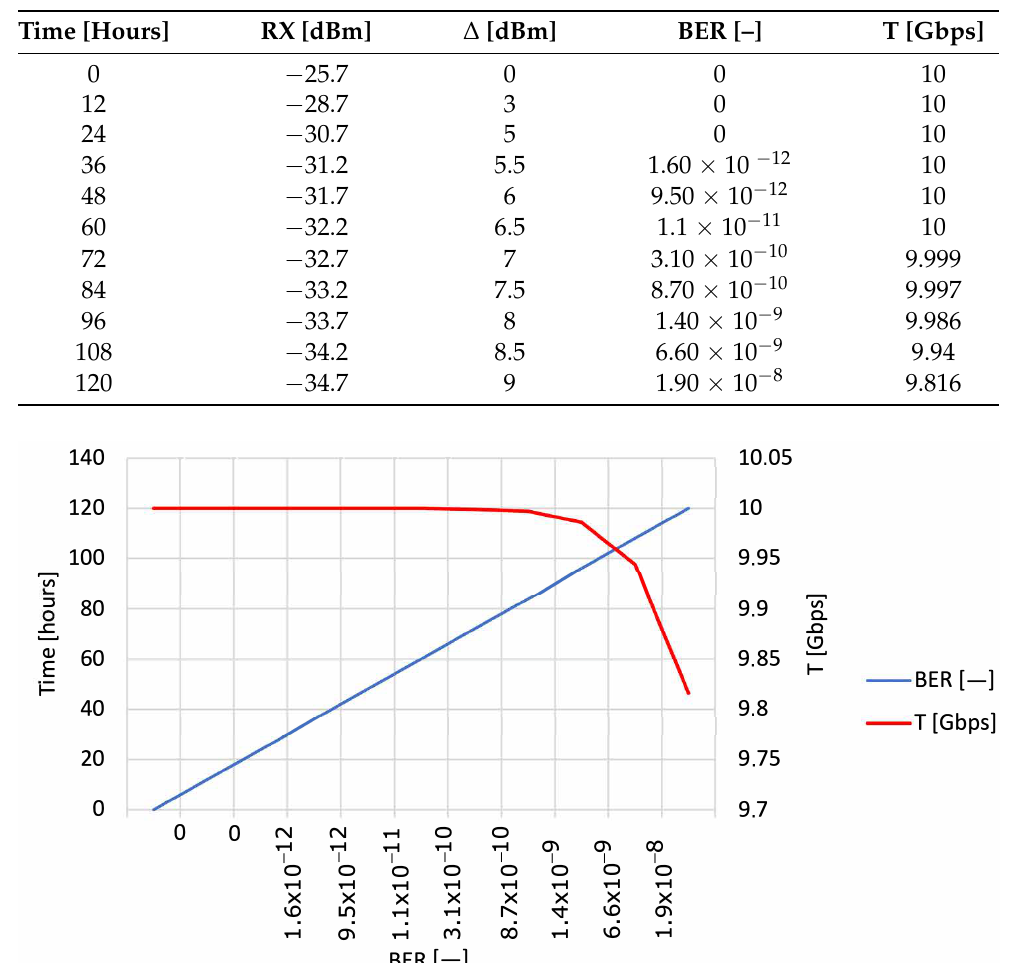
Table 1. BER and throughput changes in time.